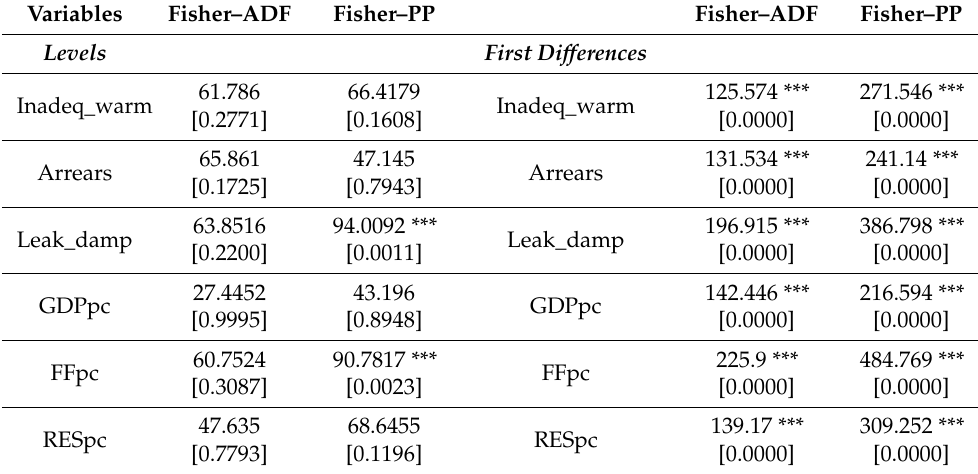
Table 4. Fisher-ADF and Fisher-PP panel unit root tests.